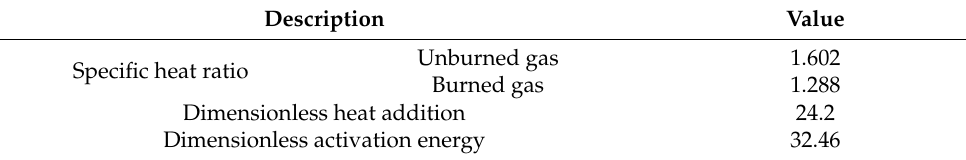
Table 3. The initial condition of numerical analysis of the tri-arc RDE.